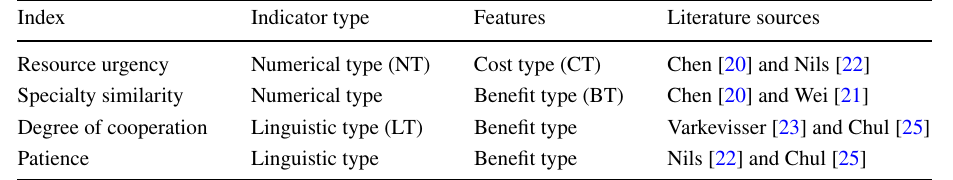
Table 1 Evaluation index set of hospitals for patients